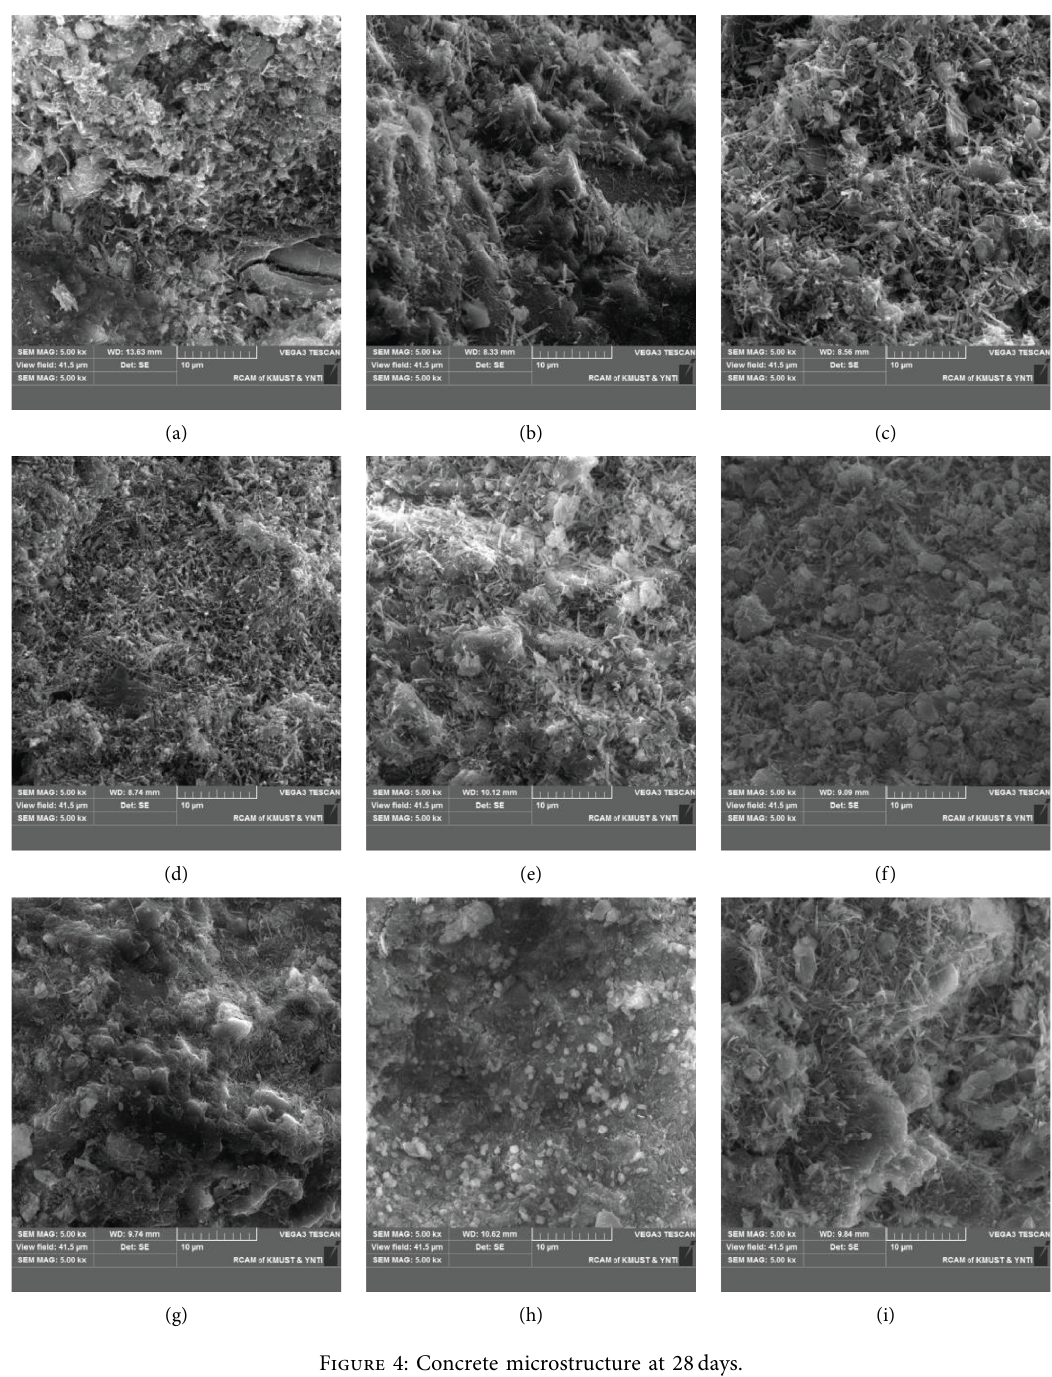
Figure 4: Concrete microstructure at